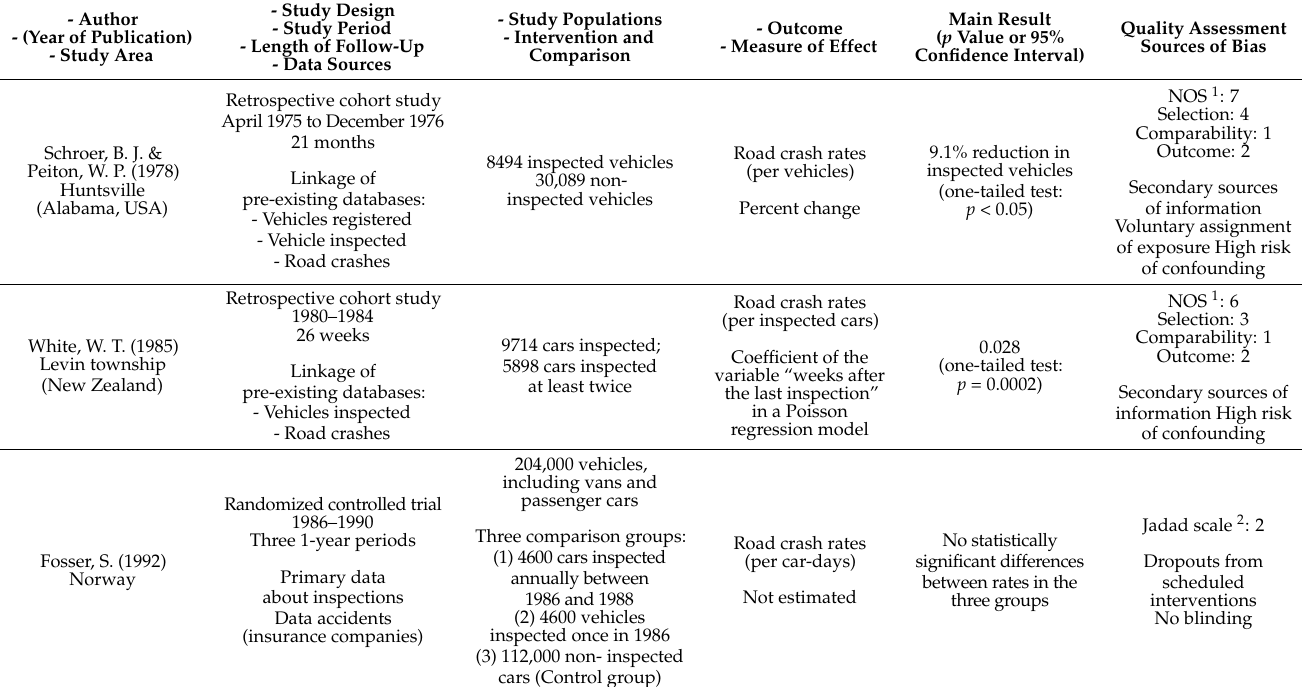
Table 1. Main characteristics of the selected